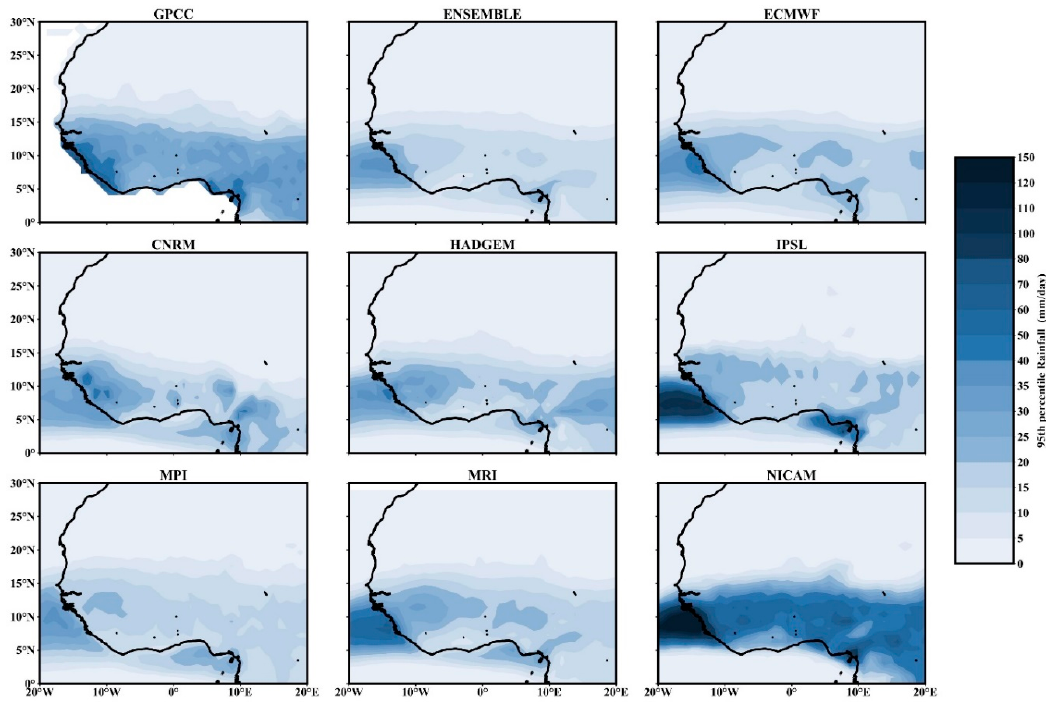
Figure 7. The contrast of spatial pattern of 95th percentile mean precipitation (1985–2014) between GCM and the observation data (GPCC) over West Africa from June to September. Atmosphere 2020 , 11 , x FOR PEER REVIEW